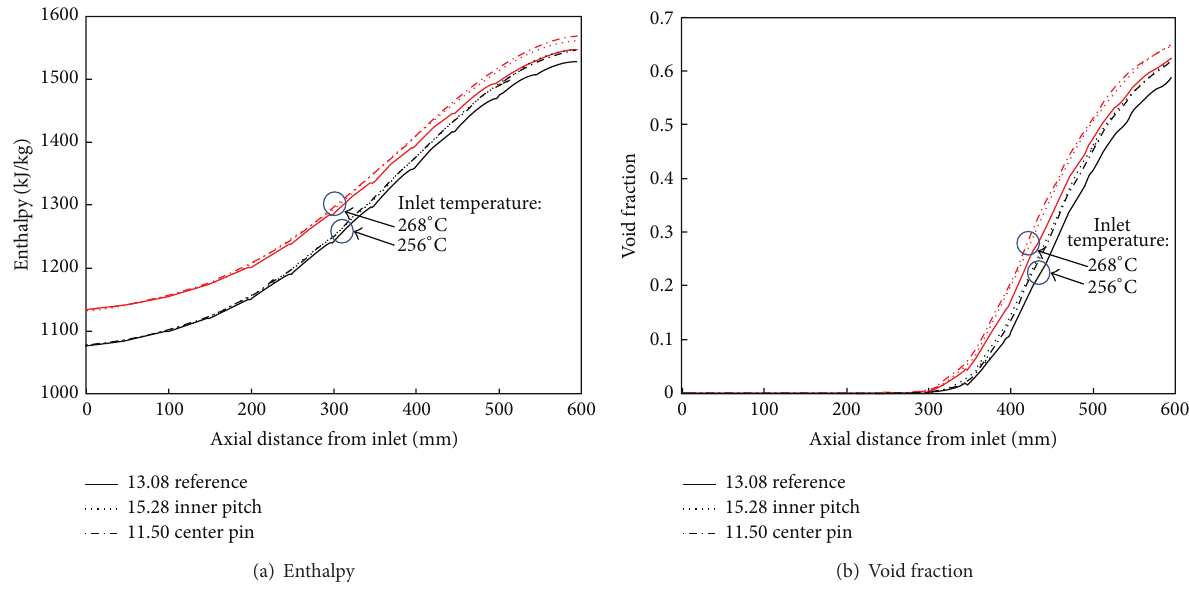
Figure 7: Enthalpy and void fraction distributions of the 37S fuel bundle, inner pitch, and center element modifications.